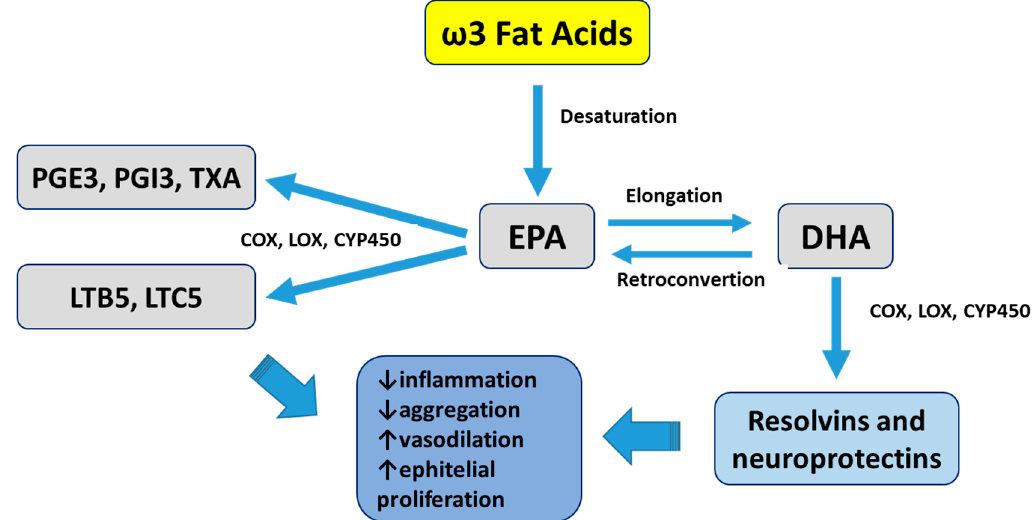
Figure 3. Eicosanoids from the ω 3 family. ω 3 series prostanoids are PGE3, PGI3, and TXA3; and ω 5 series leukotrienes are LTB5 and LTC5. PGE3: prostaglandin E3; PGI3: prostaglandin I3; TXA3: thromboxane A3; LTB5: leukotriene B5; LTC5: leukotriene C5; COX: cyclooxygenase; LOX: